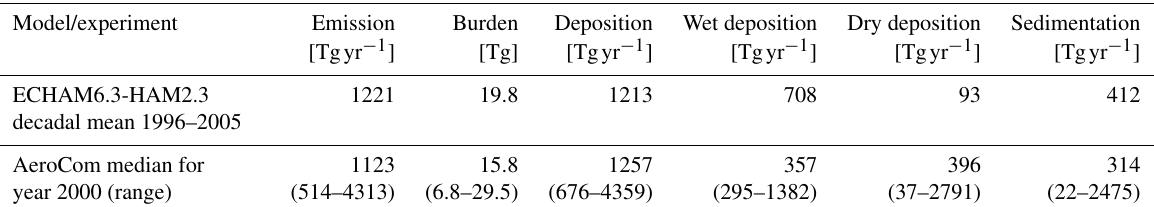
Table 1. Comparison of key values characterizing the global dust cycle budget between the model used in this study, ECHAM6.3-HAM2.3, and the AeroCom median resulting from an intercomparison of 14 different atmosphere models for present-day climate conditions (Huneeus et al., 2011).